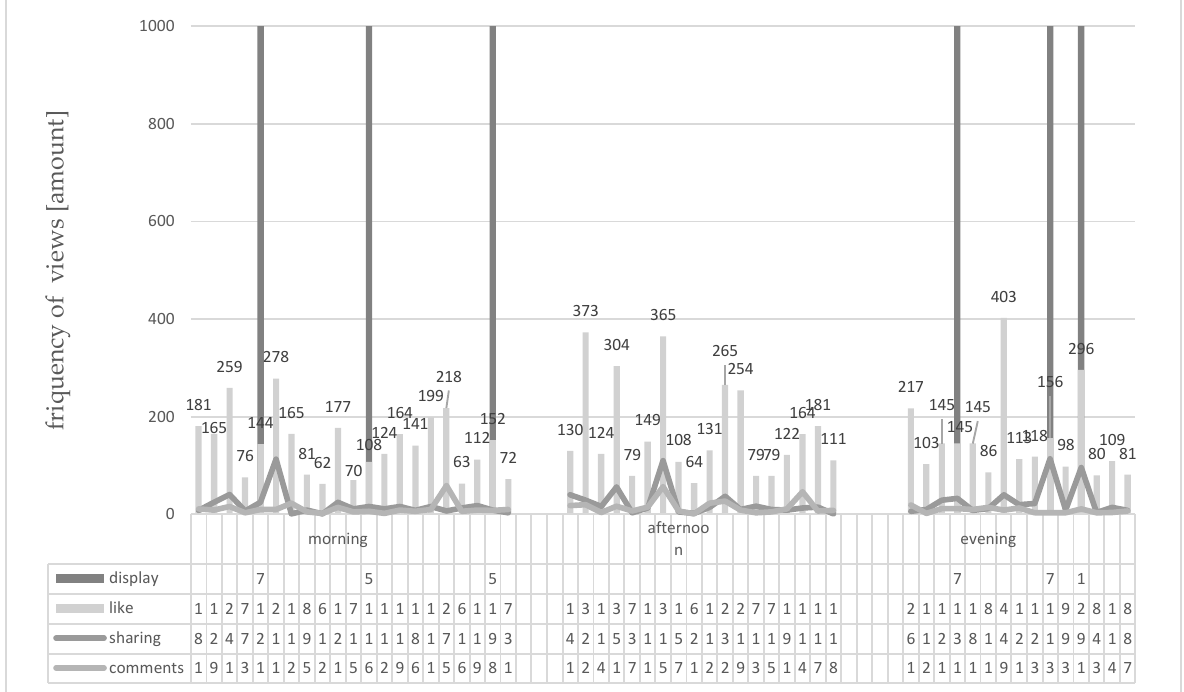
Figure 3. Summary of the intensity of engagement of Facebook users between 1 and 21 January 2019. Source: authors ’ own elaboration based on Facebook data.